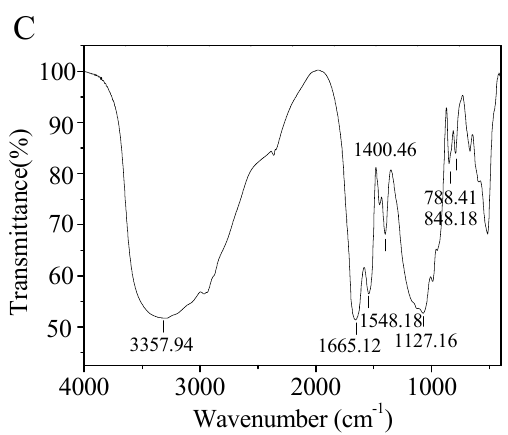
Figure 4. Characterization of PSPE. ( A : UV scanning spectrum; B : HPLC elution profile; C : FT-IR spectrum).